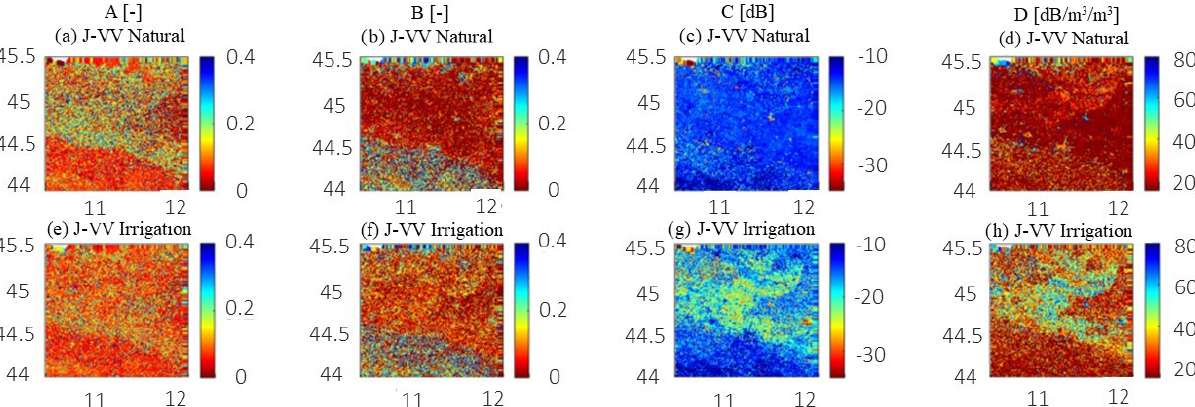
Figure 9. Maps of the (a) A parameter, (b) B parameter, (c) C parameter, and (d) D parameter for the J -VV natural calibration experiment. Maps of the (e) A parameter, (f) B parameter, (g) C parameter, and (h) D parameter for the J -VV irrigation calibration